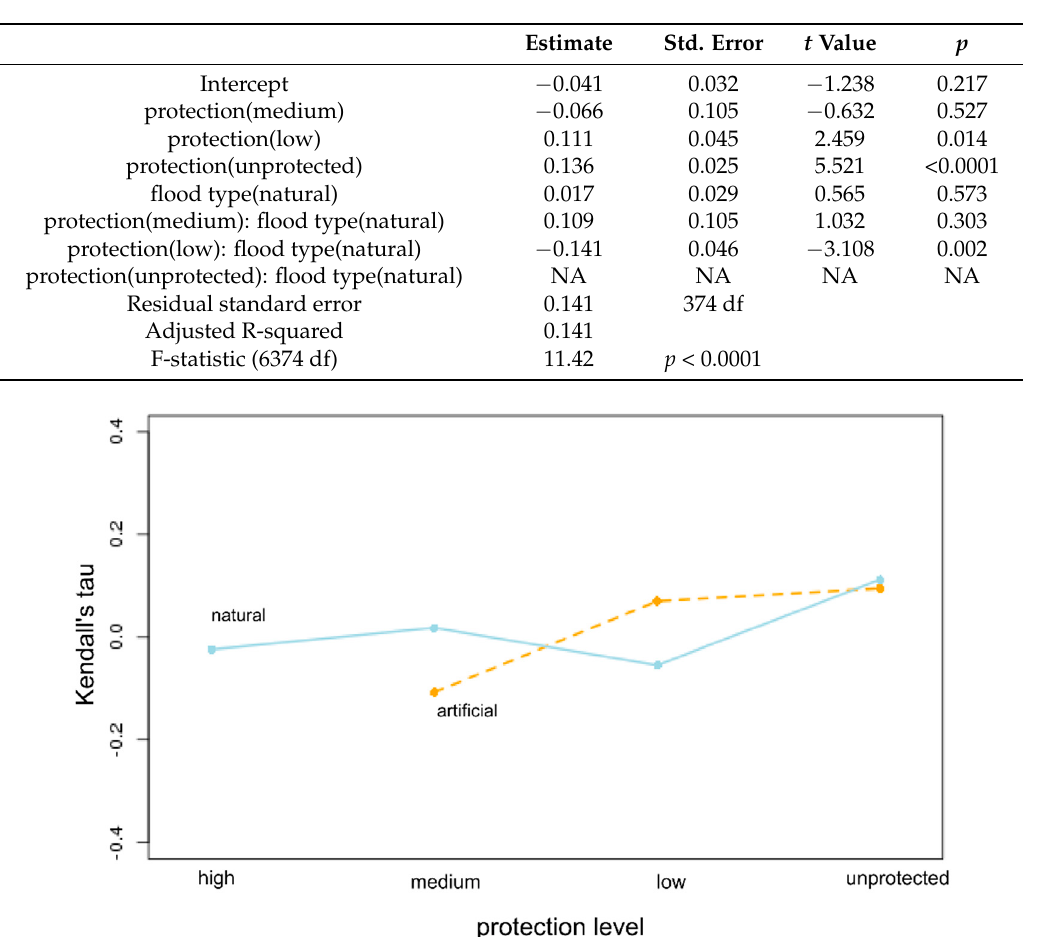
Table 4. Linear model for temporal trend in hydroperiod corrected for precipitation (Kendall’s tau) obtained by simplification from a full model with interactions considering the factors: protection level (four levels) and flood type (two levels), distance to irrigated cultures, and distance to residential areas (log transformed). n = 381 water bodies.